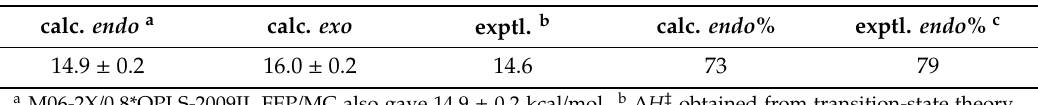
Table 1. Free Energy of Activation, ∆ G ‡ (kcal / mol), at 25 ◦ C for the Diels-Alder Reaction Between Cyclopentadiene and Methyl Acrylate in [BMIM][PF 6 ] Computed Using M06-2X / OPLS-VSIL free energy perturbation and Monte Carlo sampling (FEP / MC).